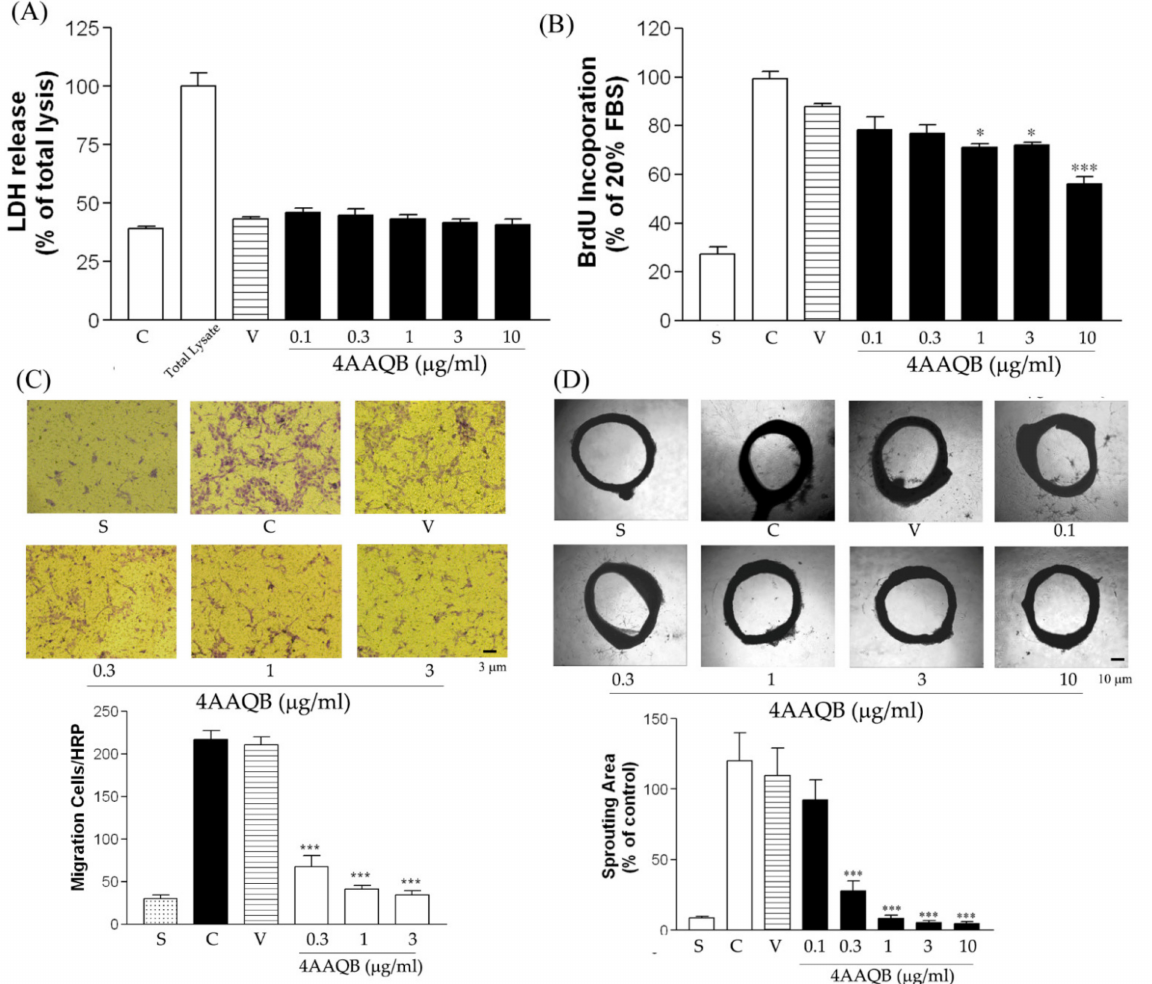
Figure 4. The effects of 4AAQB on HUVEC proliferation and in vitro and ex vivo migration: ( A ) LDH release was detected according to the manufacturer’s protocol. Data are represented as means ± SEM ( n = 6); ( B ) HUVEC cell viability was detected by the BrdU assay. Data are represented as means ± SEM ( n = 4); ( C ) migrated HUVEC in the underside filter membrane were quantified (three fields per filter) by phase-contrast light microscopy. Data are represented as means ± SEM ( n = 6). The cell numbers were calculated; ( D ) rat aortic rings were photographed and the sprouting area was calculated and represented as mean ± SEM ( n = 6). * p < 0.05 and *** p < 0.001 as compared to the control (C) groups. S indicates the starvation